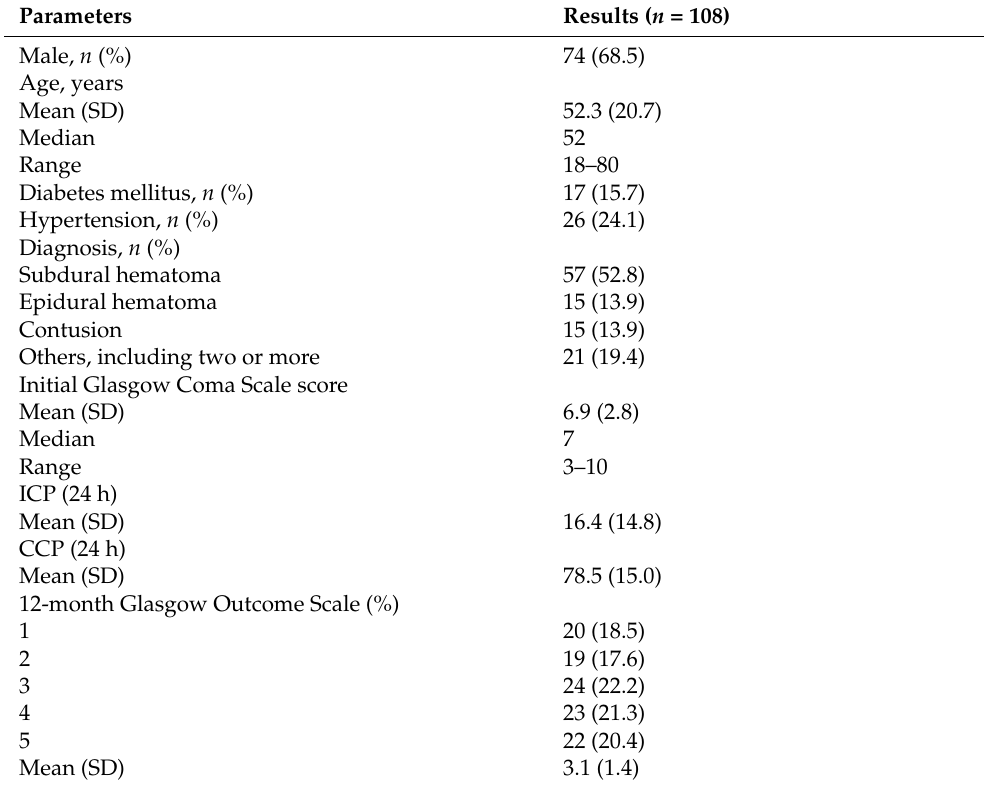
Table 1. Clinical parameters of patients ( n =